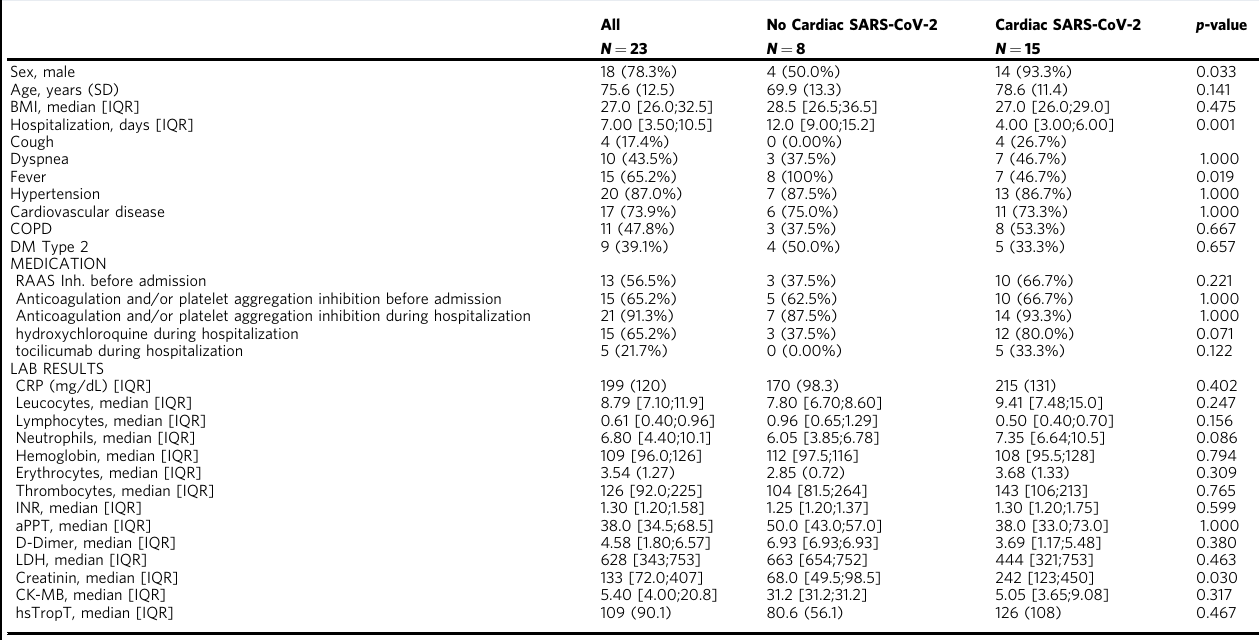
Table 2 Clinical characteristics such as demographics, comorbidities, medication, and laboratory results of 23 autopsy cases with lethal COVID-19 course.